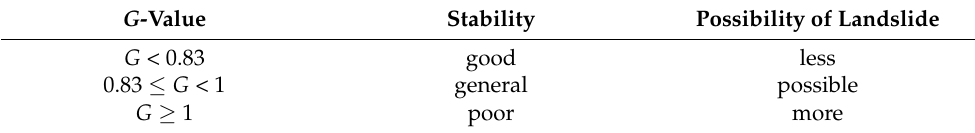
Table 3. Slope stability classification and landslide probability classification.